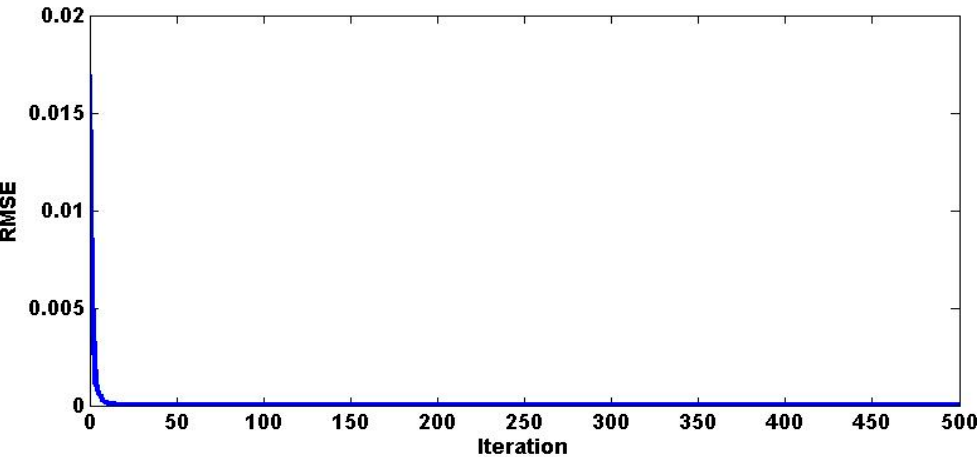
Figure 6. MTDM convergence rate using EHO.